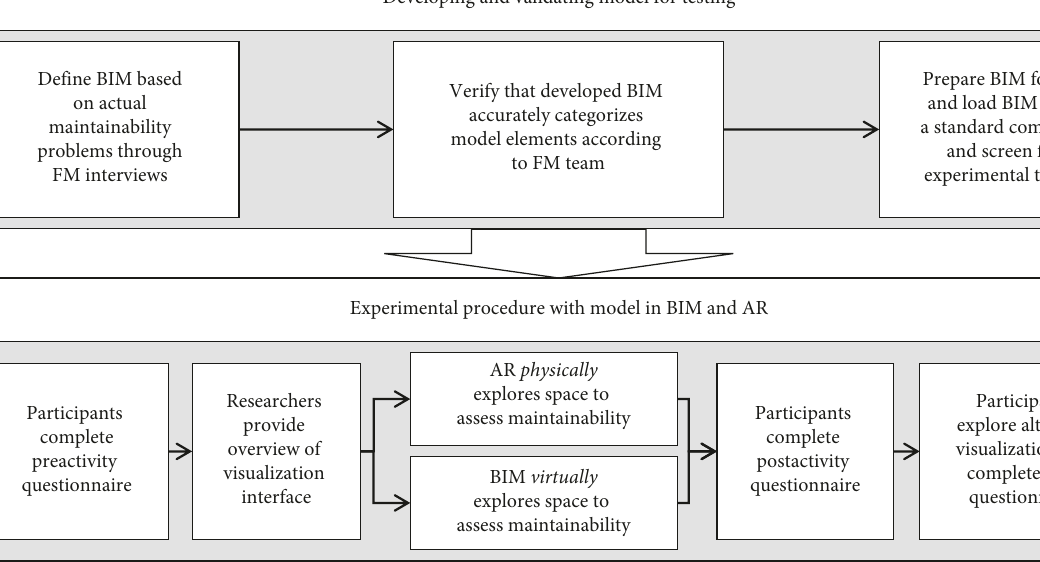
Figure 1: Model development and methodological approach followed by researchers. Table 1: Accessibility categories and their